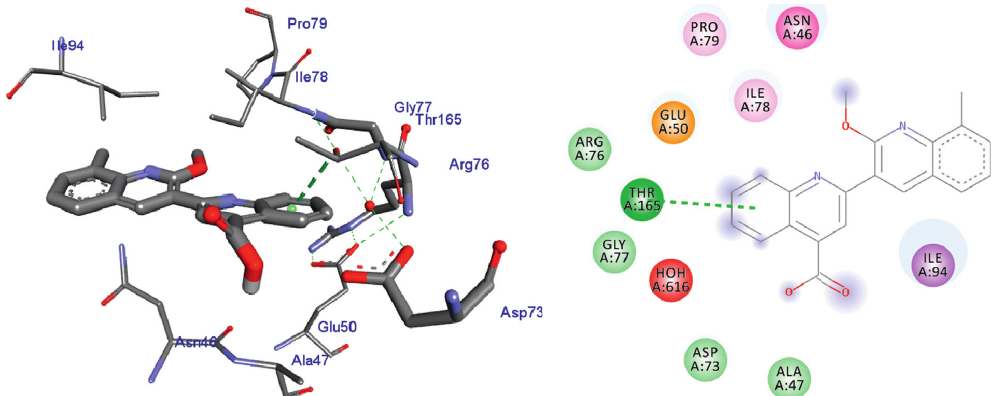
Figure 5: The binding interactions of 9 against E. coli DNA gyrase A (PDB ID :6F86).